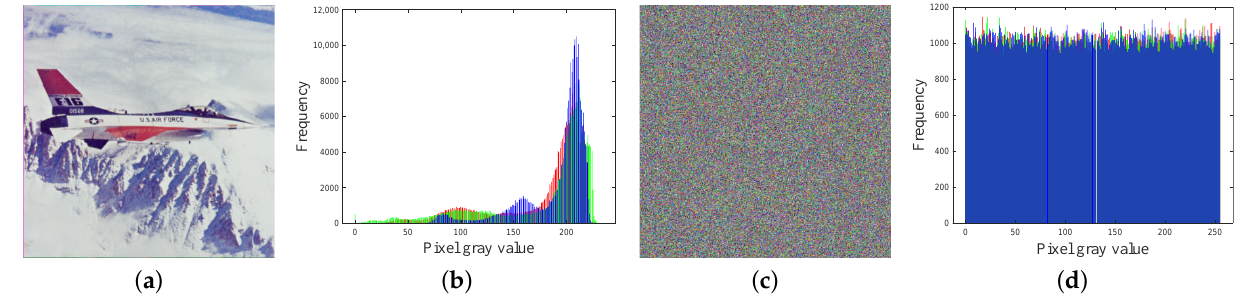
Figure 9. Image and histogram before and after bit-level scrambling and DNA encryption: ( a ) Plain image of 1 # ; ( b ) Histogram of the plain image of 1 # ; ( c ) Cipher image of 1 # ; ( d ) Histogram of the ciper image of 1 # .